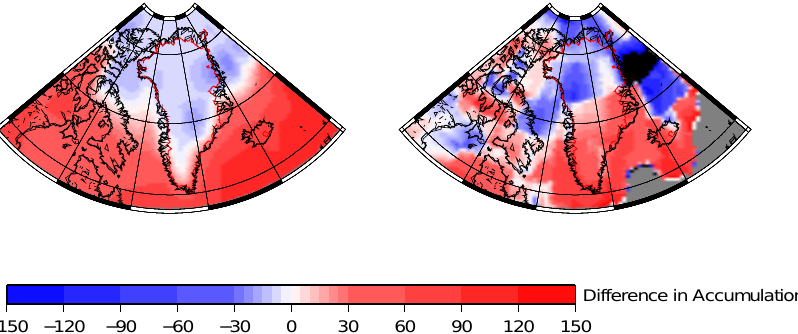
Figure 12. Difference of accumulation in %: (a) between the snow accumulation method and the precipitation accumulation methods in the CTRL experiment (precipitation-snow)/precipitation, and (b) between the PRECIP and the SNOW run (PRECIP-SNOW)/PRECIP. Grey areas correspond to areas without accumulation in PRECIP (as can be seen in Fig. 13e); division by 0 causes an error which is expressed by grey